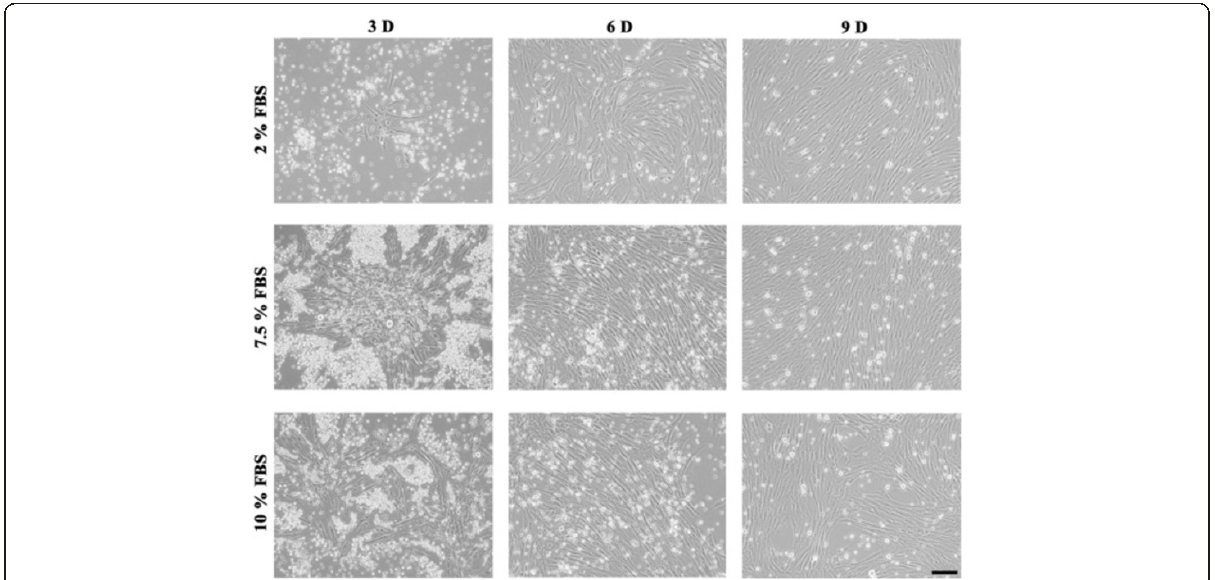
Figure 2 Effects of serum concentrations on EPCs in cultures. Unselected mononuclear cells were cultured in M 200 or M 200 supplemented with 7.5% or 10% FBS, observed on day 3, day 6 and day 9. Cells in the medium supplemented with FBS grew faster than in medium without FBS supplementation, but cells in the medium supplemented with 7.5% FBS proliferated better than in the medium supplemented with 10% FBS. Bar =100 μ